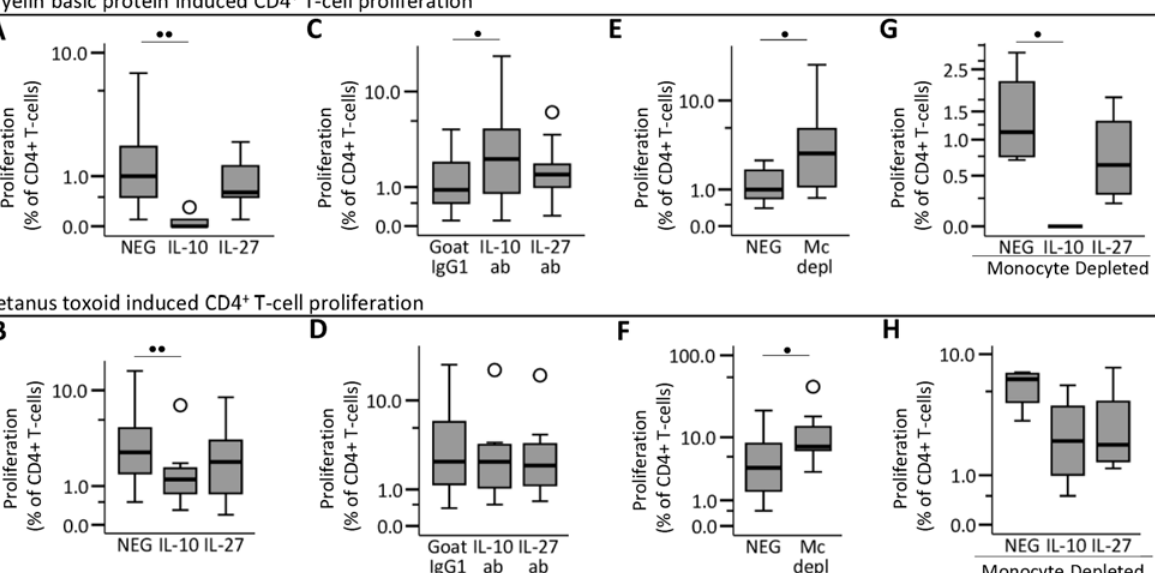
Fig 4. The effect of IL-10, IL-27 and monocytes on MBP-specific CD4 + T-cell activation. Freshly isolated PBMCs were stained with CFSE and cultured 7 days in RPMI-medium supplemented with 5% AB-serum and myelin specific protein (MBP;30 μ g/ml) or tetanus-toxoid (TT;10 μ g/ml). day 7 cells were stained with fluorochrome-conjugated antibodies and analyzed by flow cytometry. Effects on (A) MBP-induced and (B) TT-induced CD4 + T-cell proliferation when IL- 10 (5ng/ml) or IL27 (40 ng/ml) was added to the culture (n = 9); effects on (C) MBP-induced and (D) TT-induced CD4 + T-cell proliferation when endogenous IL-10 or IL-27 was inhibited by adding neutralizing IL-10-antibody (6 μ g/ml) or IL-27-antibody (6 μ g/ml; n = 9) to the culture; effects of monocyte depletion (Mc depl) from the PBMC preparations on (E) MBP-induced and (F) TT-induced CD4 + T-cell proliferation (n = 7); effects on (G) MBP-induced and (H) TT-induced CD4 + T-cell proliferation when IL-10 or IL27 was added to monocyte-depleted PBMC cultures (n = 4). Boxes represent interquartile range, median value indicated as a line, whiskers represent range, ₀ = outliers, * = extremes. Studies were made on the sub-study 5 population. Statistical analysis was by paired t-test: (cid:129) = p < 0.05; (cid:129)(cid:129) = p < 0.005.